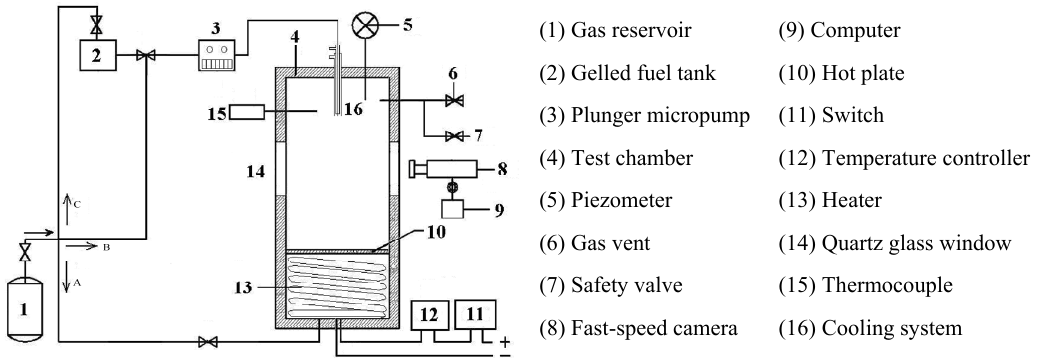
Figure 1. Schematic of the experimental